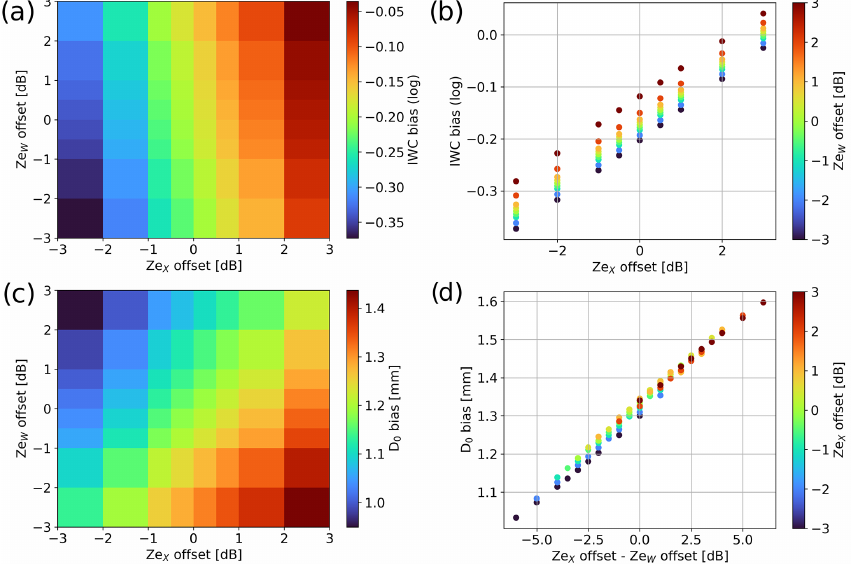
Figure 12. (a) Heat map of IWC bias as a function of X- and W-band reflectivity offset; the bias is computed using the aircraft values as reference. (b) Different visualization showing IWC bias as a function of Ze X offset. (c) As for panel (a) but for D 0 . (d) As for panel (b) but for D 0 and offset in the dual-frequency